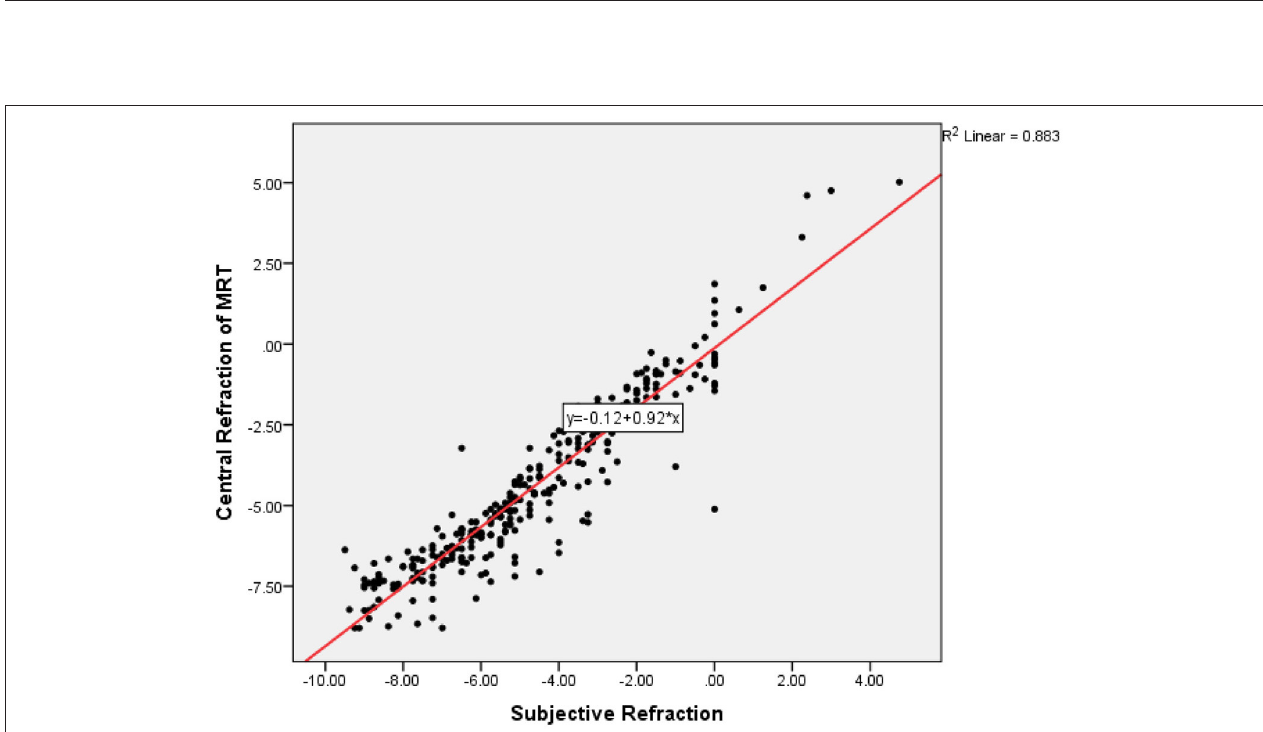
FIGURE 4 | The correlations of central refraction obtained by MRT and experienced optometrist.